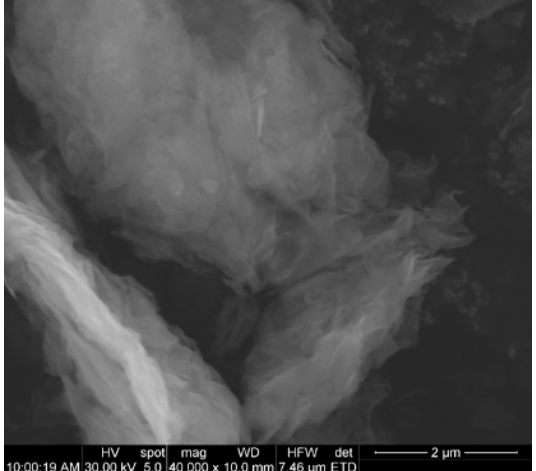
Figure 3. SEM micrographs of mineral clay.